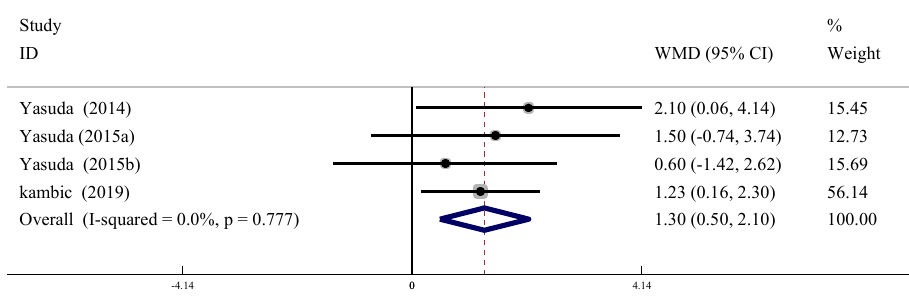
Figure 11. Meta-analysis of the effect of LL-BFR training on FMD of the older adults.